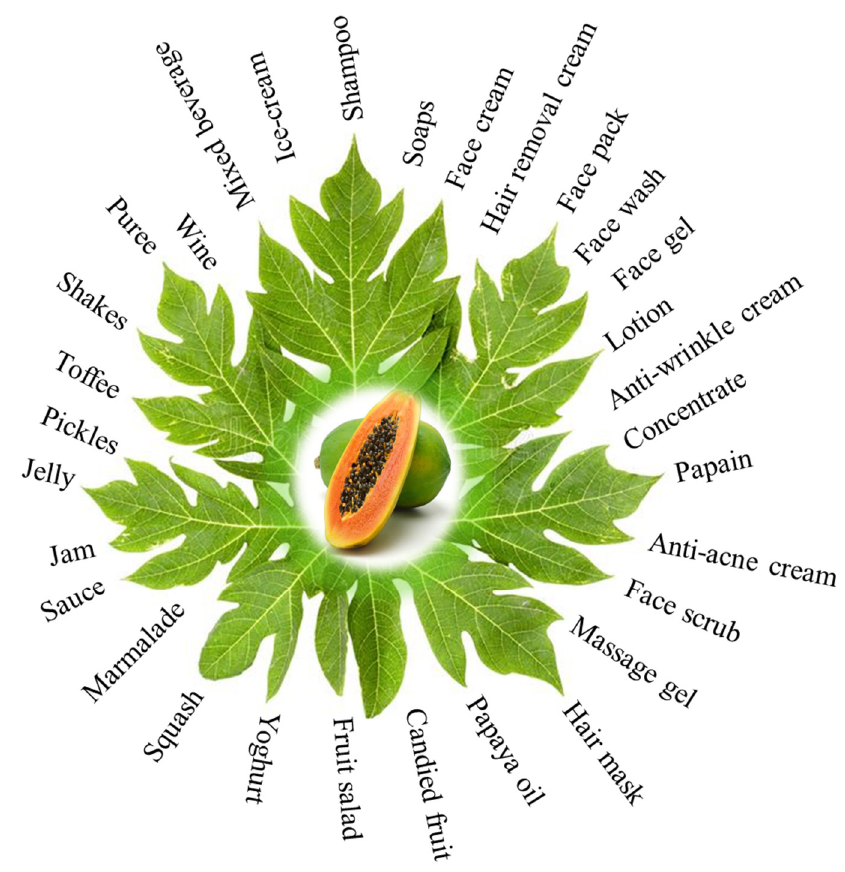
Figure 4. Value-added commercial products of Carica